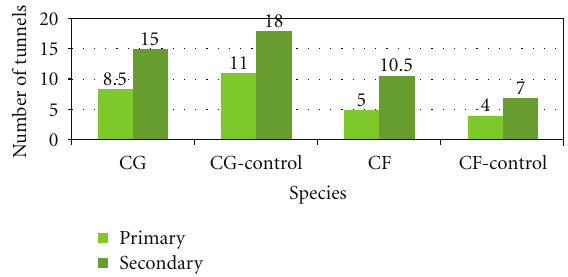
Figure 6: Number of primary and secondary tunnels in foraging arenas with (Douglas Fir and Southern Yellow Pine) and without (controls) food present. CG: C. gestroi ; CF: C. formosanus . Within each species, tunnel numbers with and without food present were not significantly di ff erent ( t -test: P = 0 .